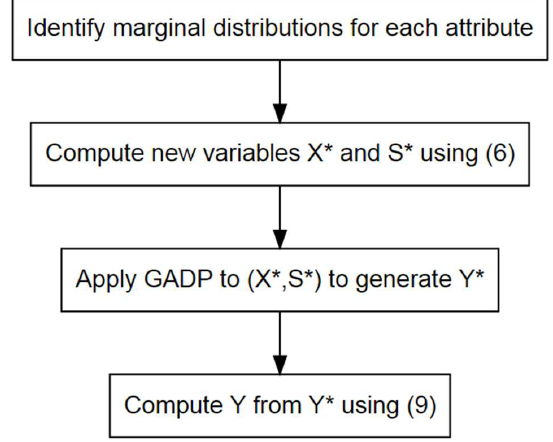
Figure 2. Procedure for applying CGADP.